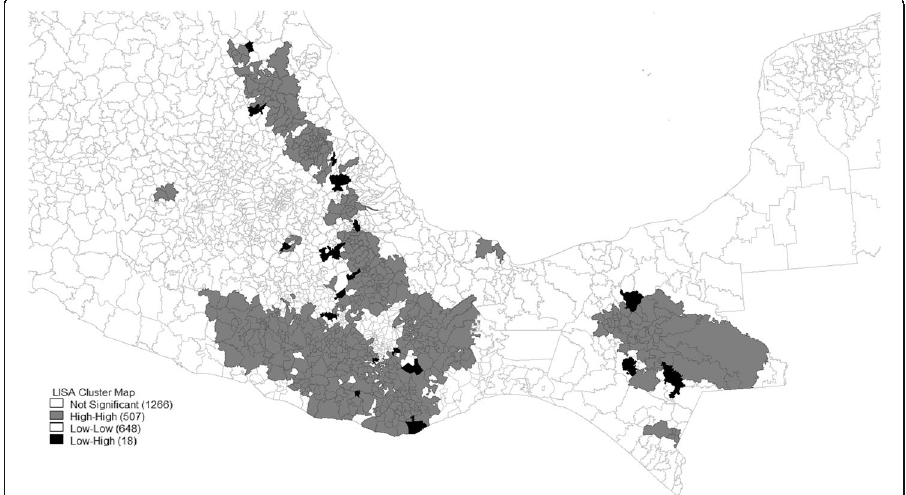
Fig. 7 LISA cluster map focusing on the southeast region. Mexico 2015. Note. high-high are the municipalities with high social lag surrounded by municipalities high social lag in grey; low-high are municipalities with low social lag surrounded by municipalities with high social lag in